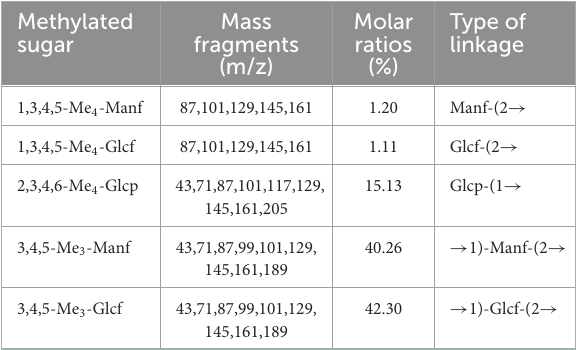
TABLE 3 Methylation analysis of the WSGP. Methylated